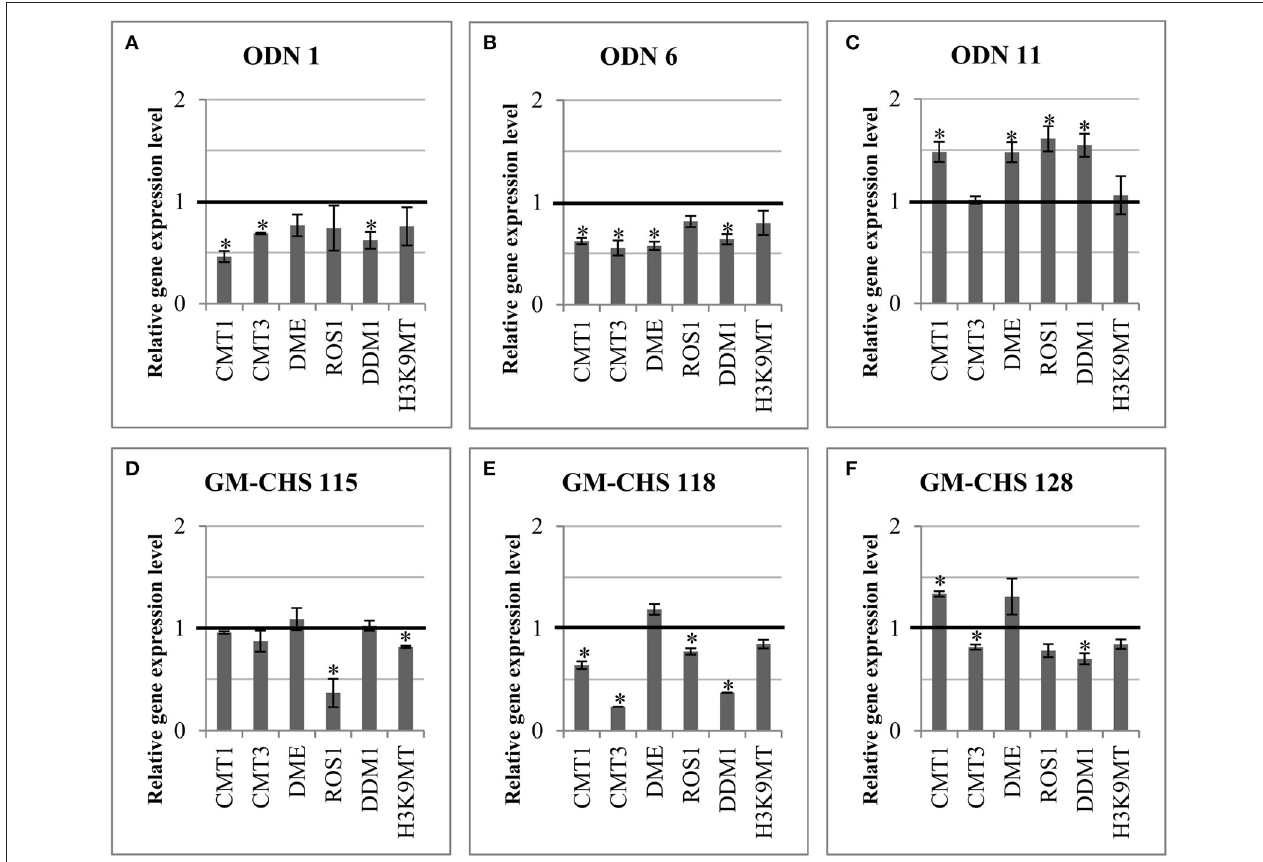
FIGURE 9 | Expression of genes involved in epigenetic modifications in ODN-treated (A–C) and transgenic (D–F) plants. Expression of the methylases ( CMT1 , chromomethylase 1; CMT3 , chromomethylase 3) and demethylases ( DME , DEMETER; ROS1 , repressor of silencing 1) and enzymes involved in chromatin methylation ( DDM1 , decrease in DNA methylation 1; H3K9MT , histone H3K9 methyltransferase) is presented for plants. The control is presented as a line in bold (set as 1). Data constitute the mean value ± SD from at least three independent experiments. The significance of the differences between each mean and control was determined by Student’s t -test. Asterisk indicates p <